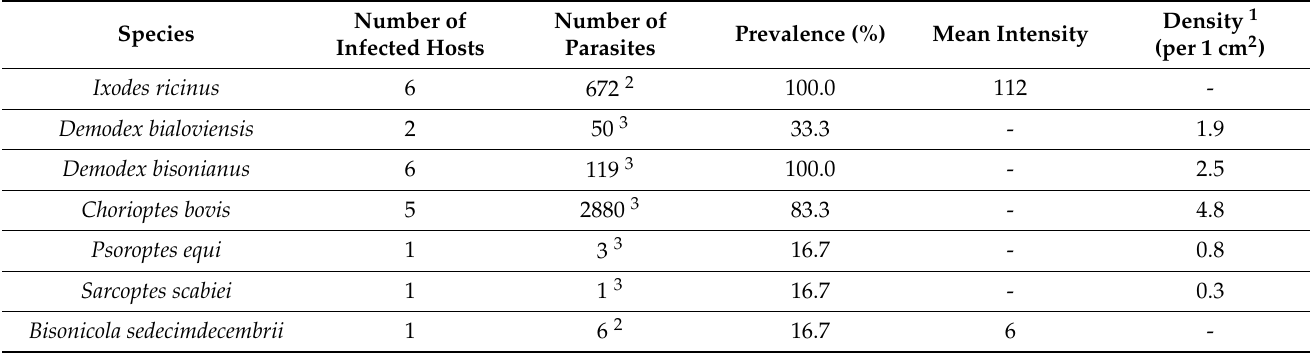
Table 1. List of parasitic arthropods in European bison according to basis infection parameters.